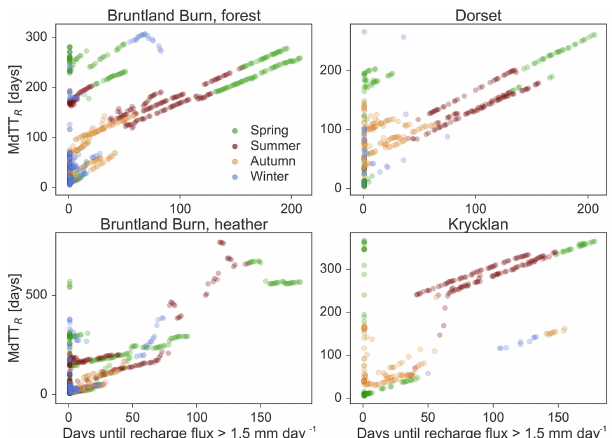
Figure 3. Median travel times in recharge flux (MdTT R ) for each study site as a function of days required to produce intense recharge fluxes (here defined as >1.5mmday − 1 ) following infiltration of the traced water into the soil. The dots show the MdTT R for each day of rain and the colour code represents the season when the traced water infiltrated the